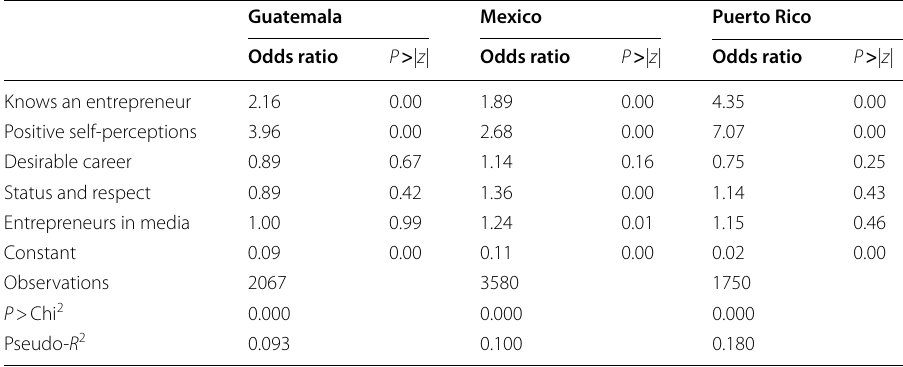
Table 4 Comparative analysis of Central and North American countries